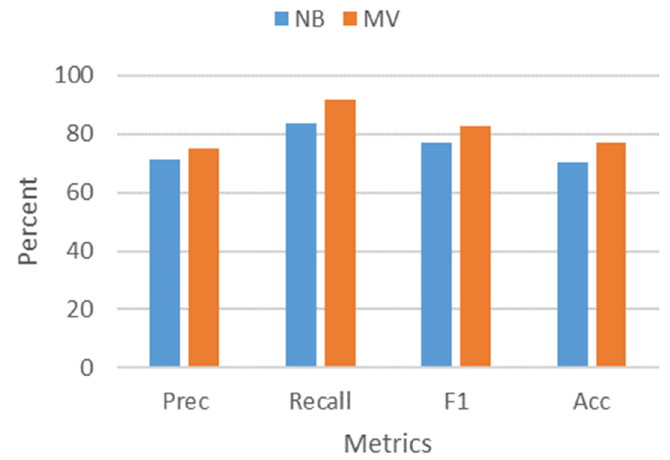
Figure 3. Performance of NB vs. MV.